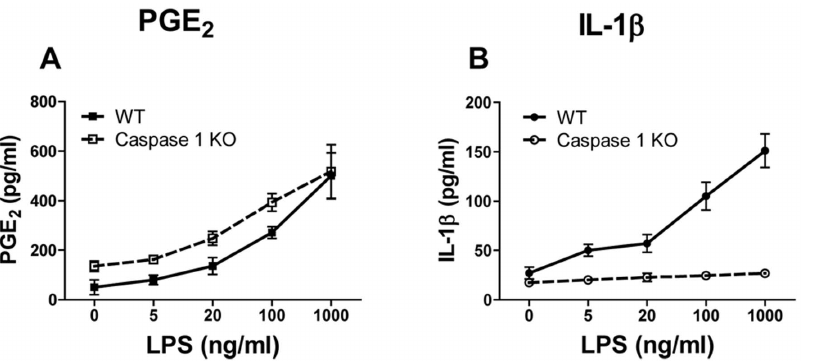
Figure 3. LPS induced PGE 2 but not IL-1 b secretion in macrophages from caspase-1 KO mice. Macrophages were isolated from the peritoneal cavity of wild type (WT, solid lines) or caspase-1 KO mice (broken lines) and were incubated in vitro with LPS for 24 h. Cell culture supernatants were assayed for PGE 2 (A) and for IL-1 b (B). The data are shown as means 6 STDEV for triplicate wells. The experiment was performed three times with similar